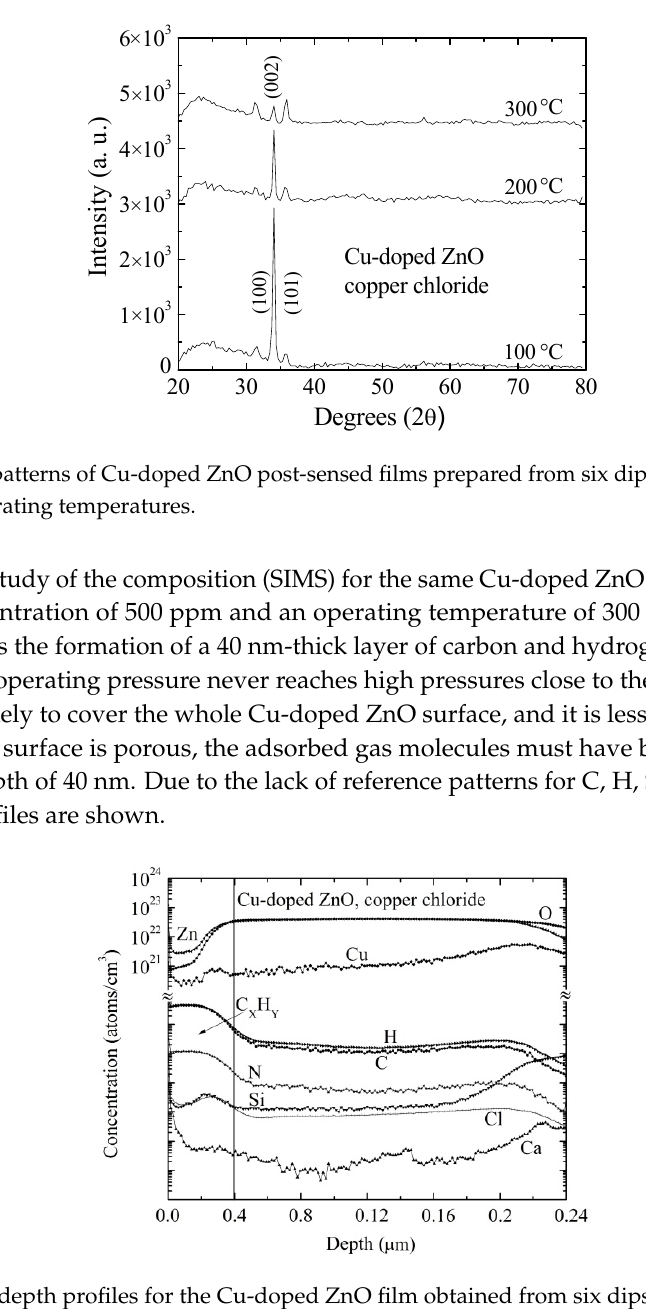
10 of 15 Figure 6. Sensitivity of an undoped ZnO film prepared with six dips as a function of the C 3 H 8 concentration at different operating temperatures. 3.4.3. Structural and Compositional Analysis of Cu ‐ Doped ZnO Post ‐ Sensed Films Obtained from Copper Chloride and CO Gas Sensitivity To obtain more information about the sensing mechanisms, X ‐ rays diffraction patterns and SIMS depth profiles of Cu ‐ doped ZnO post ‐ sensed films were obtained. Figure 7 presents the X ‐ ray diffraction patterns of Cu ‐ doped ZnO films prepared from six dips of zinc acetate and three dips of copper chloride. These Cu ‐ doped ZnO films were used to sense propane gas at three different operating temperatures, i.e. , 100, 200 and 300 °C, and under the same gas concentration of 500 ppm. From the results, it is found that as the operating temperature increases, the crystallinity of the ZnO